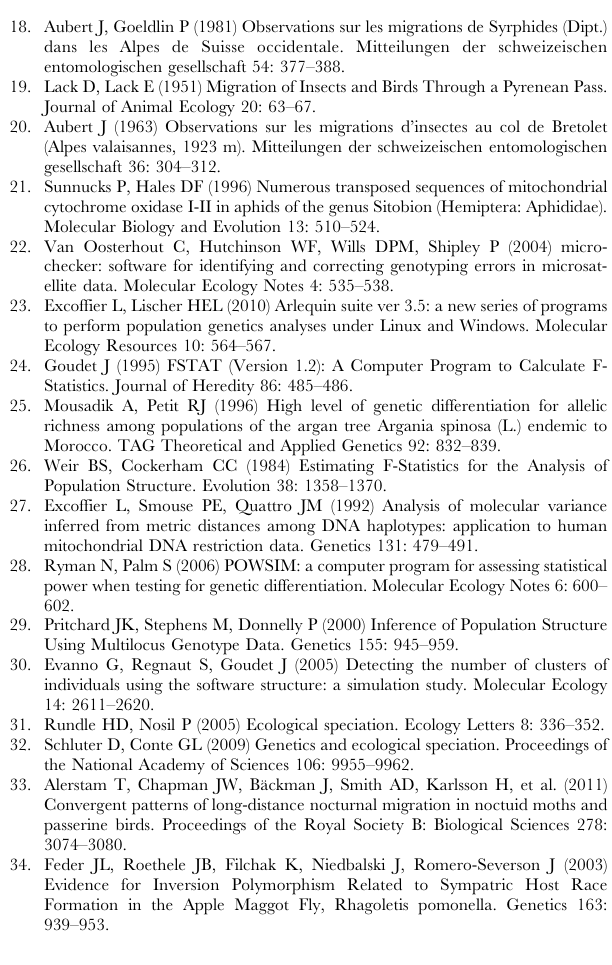
Figure S1 Expected (He) and observed (Ho) heterozygosity at each locus in the six groups. Significance differences between these